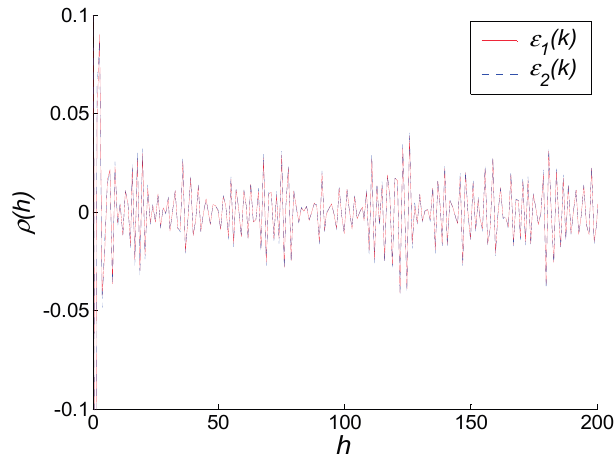
Figure 6. White noise test of two modeling